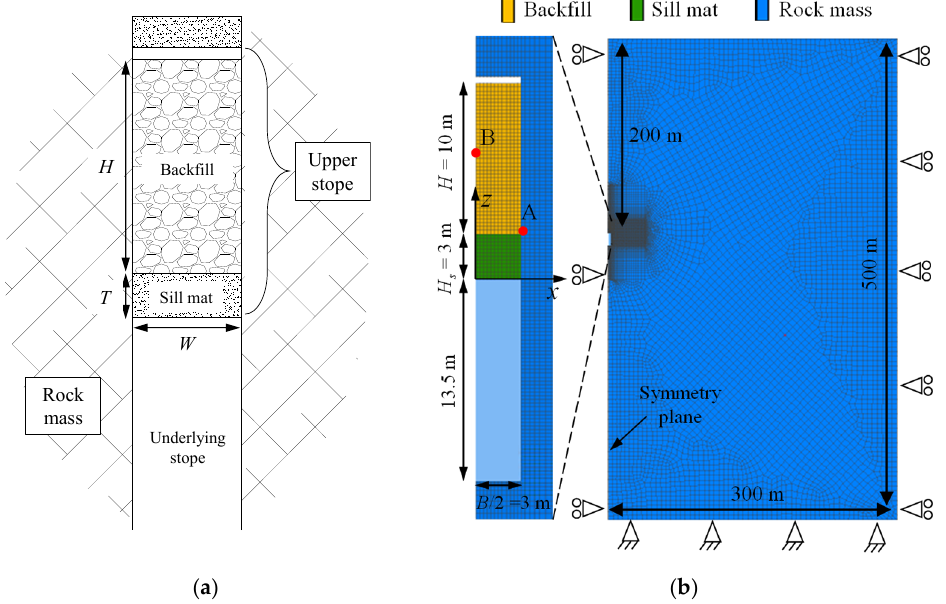
Figure 10. ( a ) Physical model and ( b ) numerical model built with FLAC 3D of an undercut below a sill mat with overlying backfill.